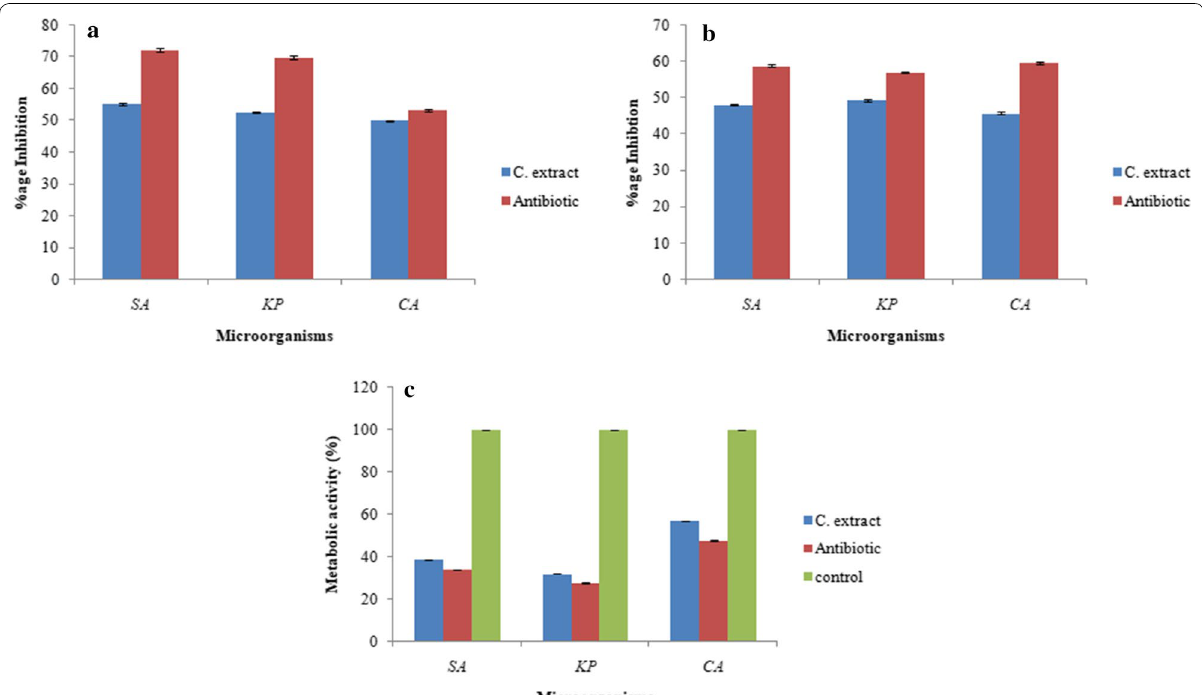
Fig. 9 Effect of chloroformic extract on a Initial cell attachment, b Performed biofilms, c Metabolic activities of treated biofilms. *SA, Staphylococcus aureus ; KP , Klebsiella pneumoniae 1 and CA, Candida